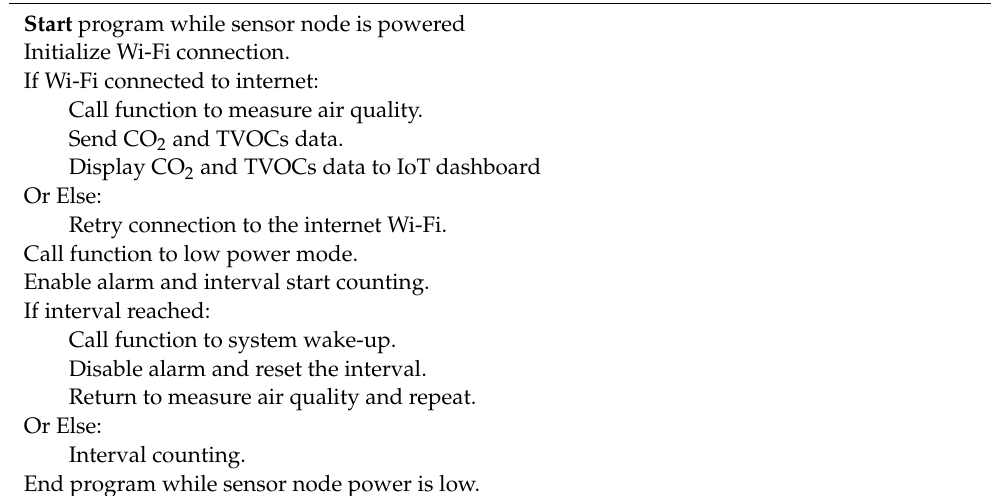
Algorithm 1 The logical flow of VOCs sensor node sensing process